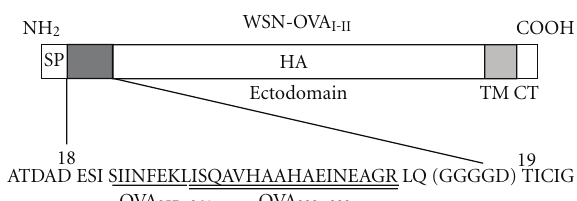
Figure 1: Constructionofthemutanthemagglutin in(HA)segment. Schematic representation of the HA/OVA I / II construct, containing the OVA epitopes inserted after the HA signal peptide (SP). CT, TM = cytoplasmic, transmembrane domains of HA,